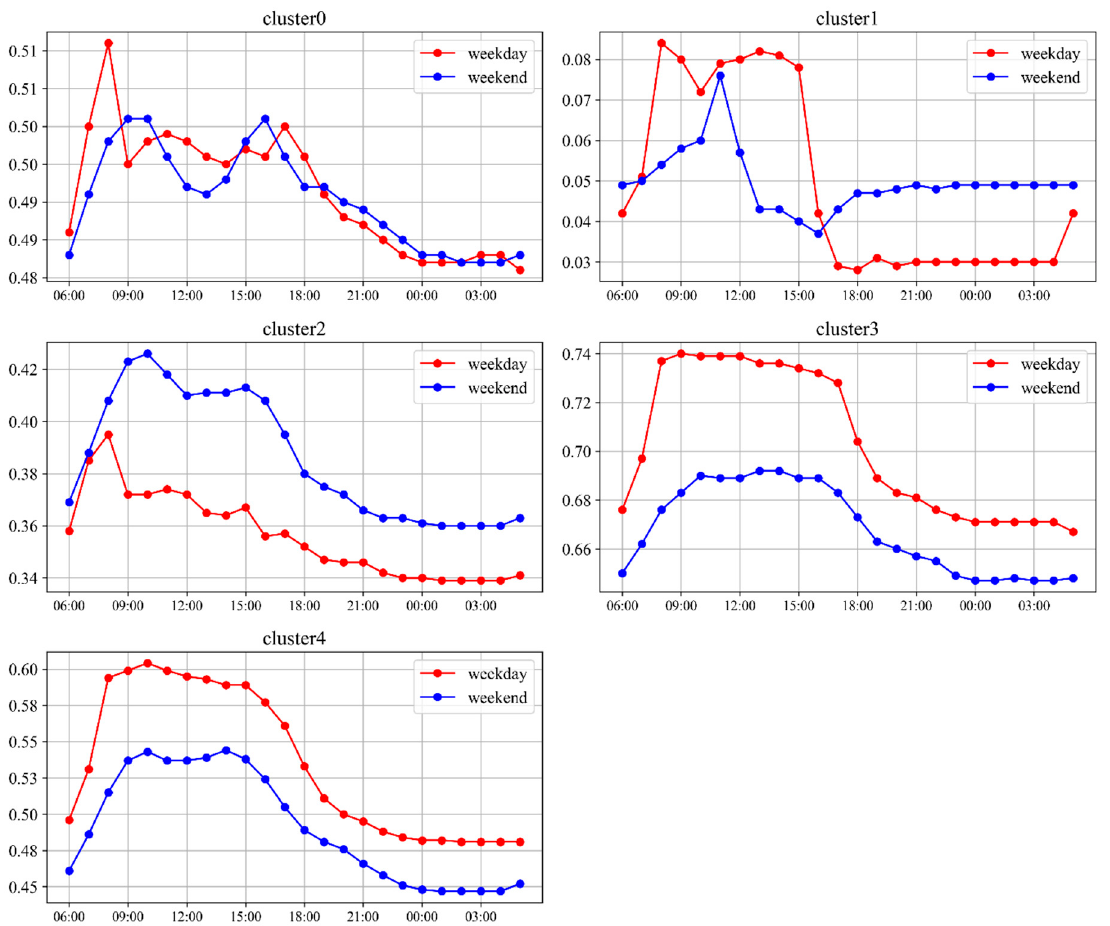
Figure 7. The daily temporal demand pattern of different clusters when k = 5.